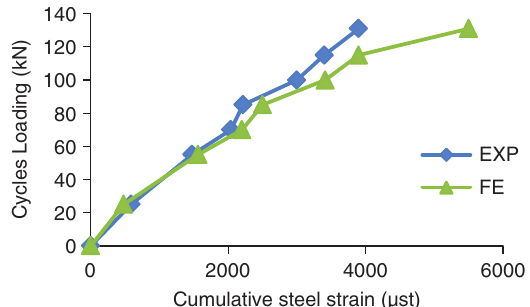
Fig. 12. Load against steel strain curves for pre-repair phase of the beam G2R1